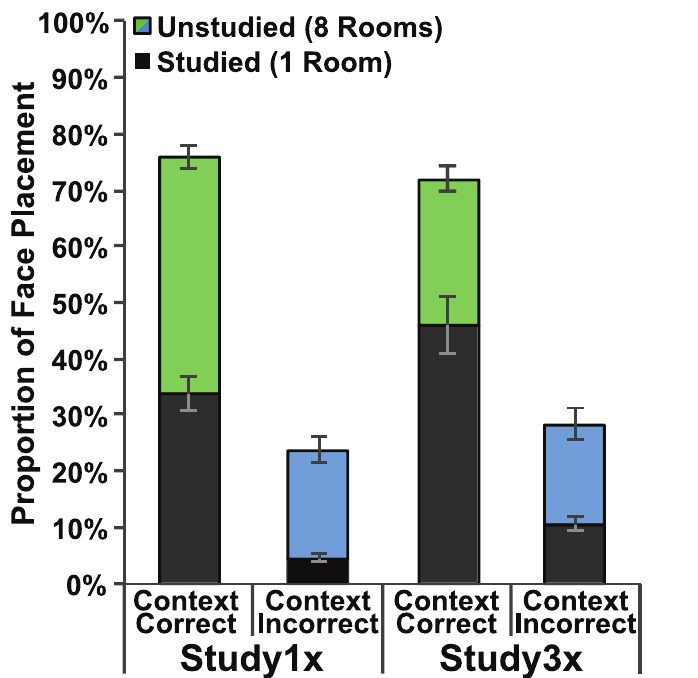
Fig 3. Behavioral performance. Proportion of face placement to rooms on the correct (green) and incorrect (blue) side of the building. Dark bars indicate face placements to the studied room on a given side whereas colored (green or blue) bars indicate face placements to any of the remaining eight unstudied rooms. Data are presented for both the Study1x and Study3x groups and standard error bars are